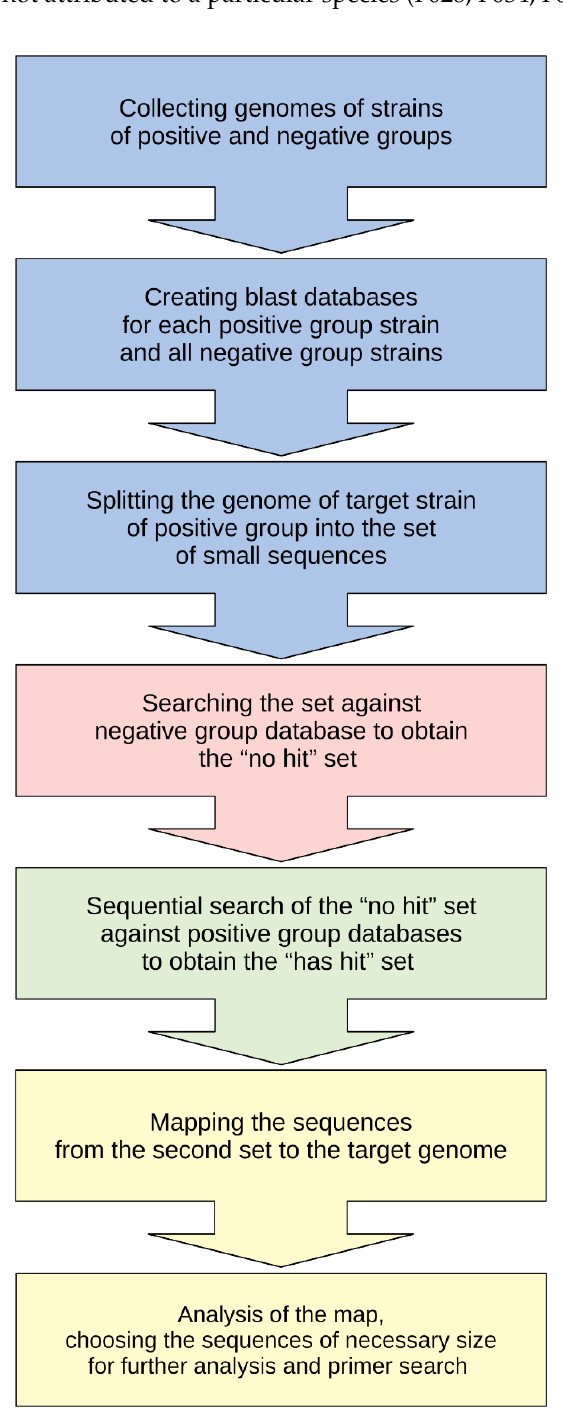
Figure 2. Flowchart of the search for species-specific sequences. The workflow includes three stages. Stage I is the preparation stage and consists of collecting the genomes, creating BLAST databases and splitting the target genome into sequences of 100 bases in length, overlapping by 90 bases, for performing BLAST searches in subsequent stages. Stage II is the search stage and consists of BLAST searches using negative and positive group databases to reveal possible species-specific regions. Stage III is the analysis stage and can include the analysis of the genome map, a BLAST search using other databases and choosing the most appropriate sequences for PCR purposes, and so on.